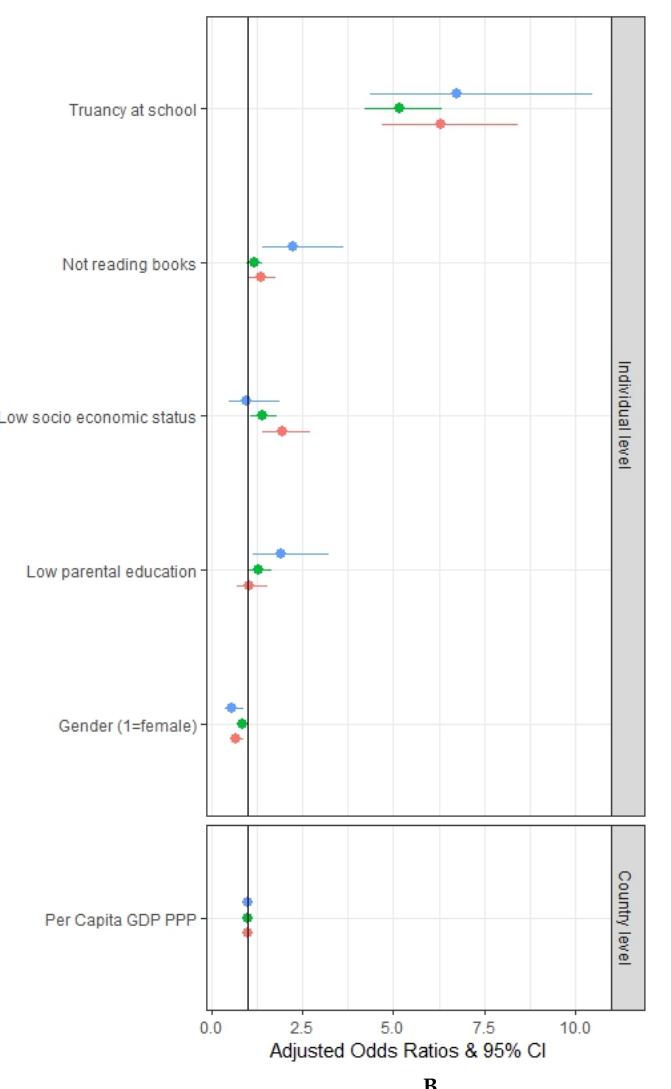
Figure 2. Multivariate multilevel mixed-effects logistic regression adjusted odds ratios with a 95% confidence interval: (A) relation between students’ socioeconomic status, parental education and the patterns of cocaine use (Experimenter, Episodic and Frequent); (B) relation between students’ socioeconomic status, parental education, truancy at school, reading books for enjoyment and the patterns of cocaine use (Experimenter, Episodic and Frequent). Authors’ elaboration on ESPAD data.